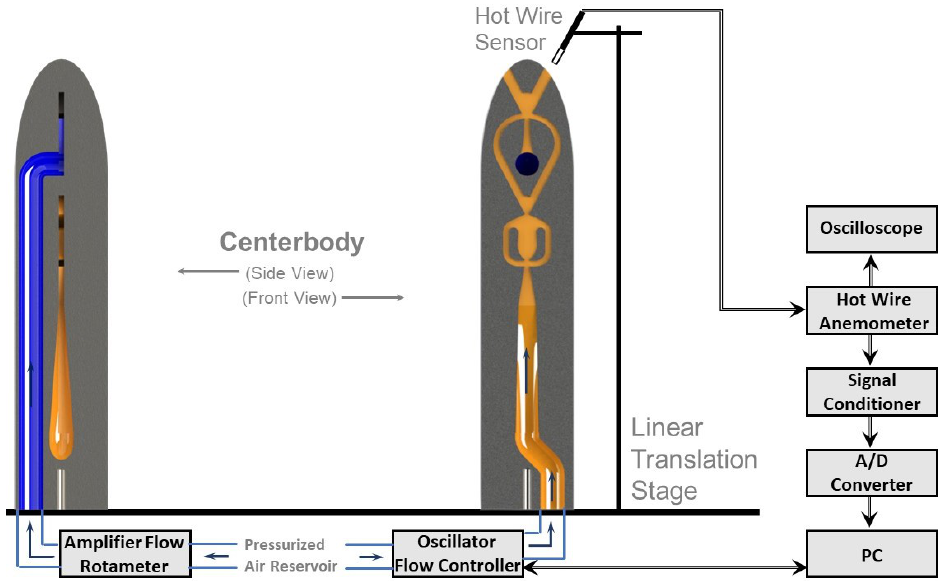
Figure 5. Hot-wire measurement setup for the measurement of the velocity of the flow at the outlet of the